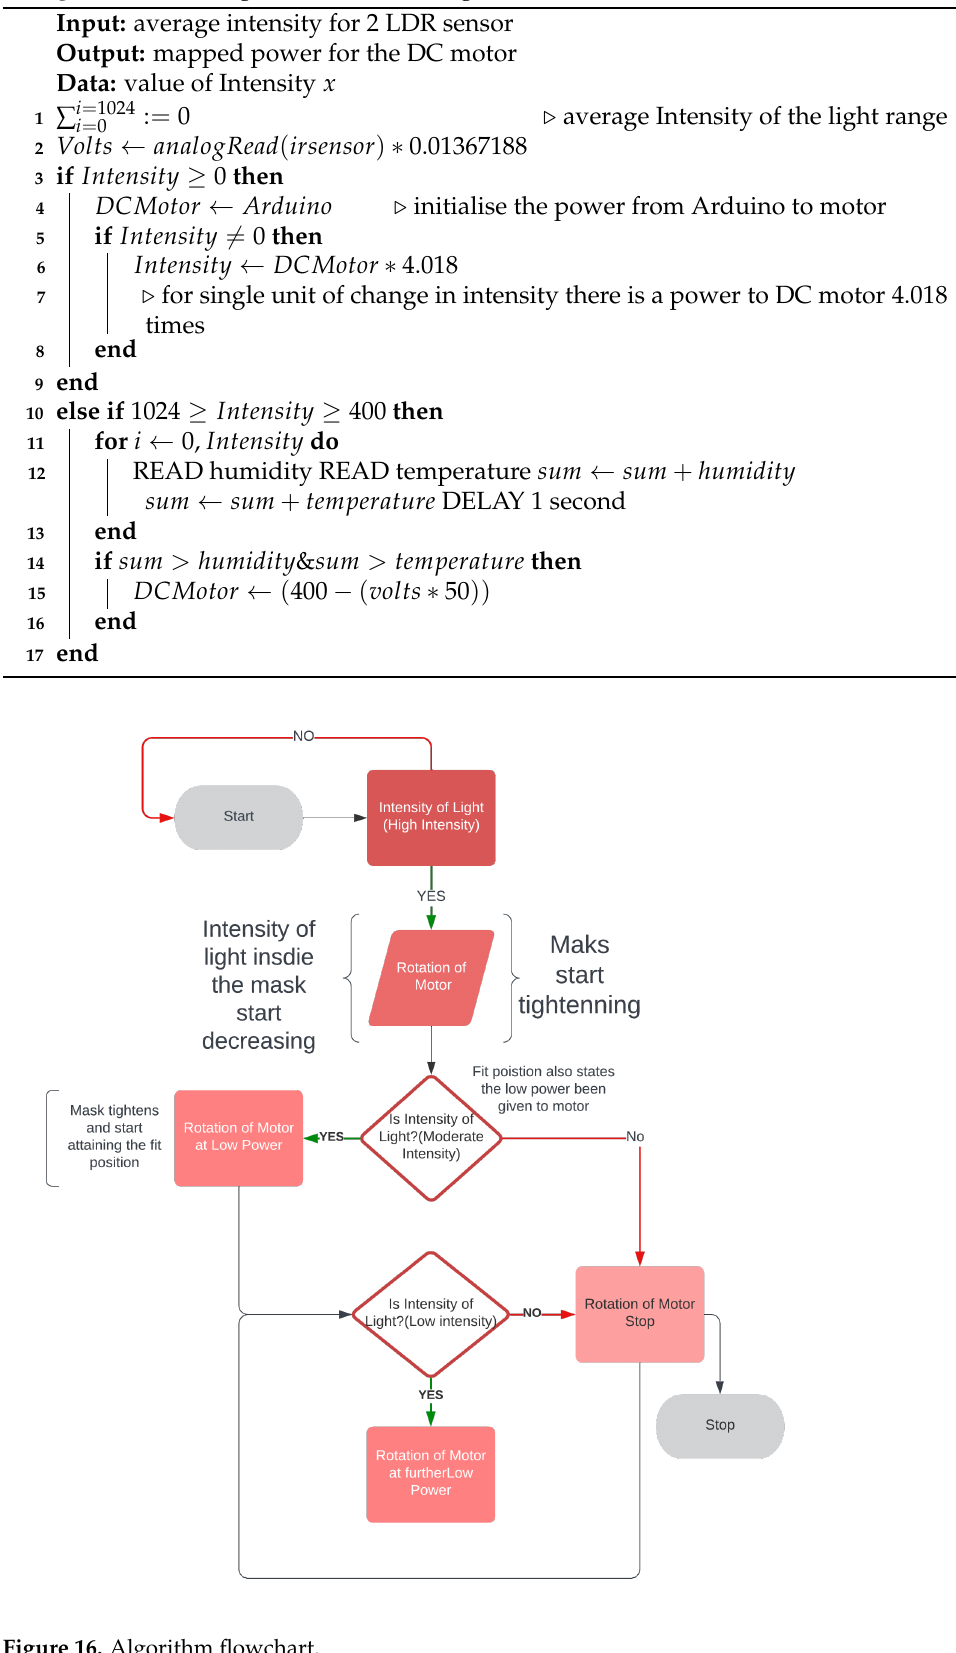
Figure 16. Algorithm